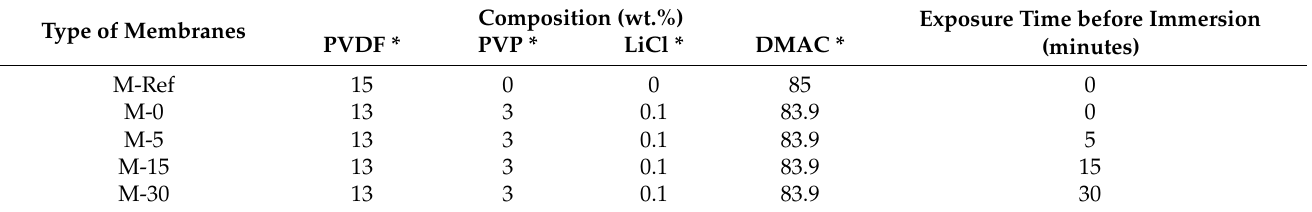
Figure 1. Illustration of membrane preparation using the vapour induced phase separation VIPS method. Table 1. Summary of membrane composition and